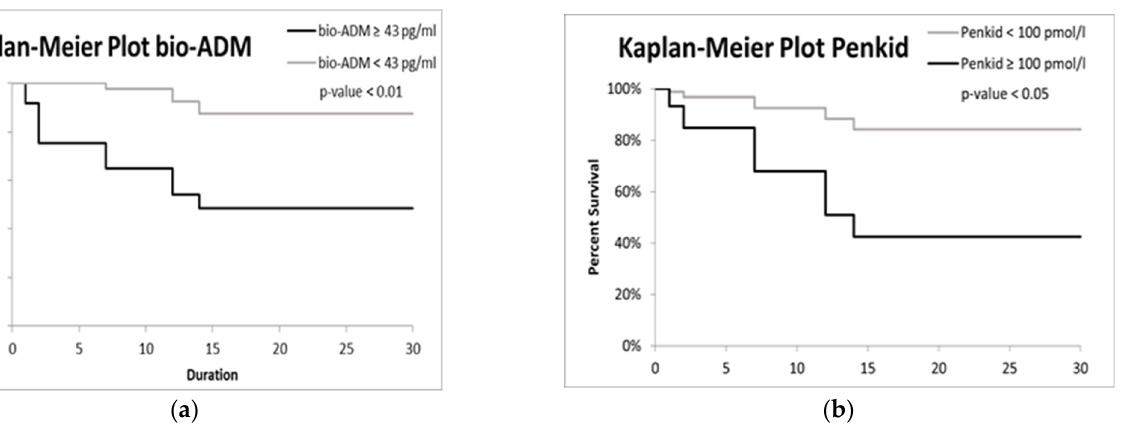
Figure 4. ( a ) Kaplan–Meier Bio-ADM curve. Grey line shows the survival rate for the patients with Bio-ADM values <43 pg/mL in the first 30 days. Black line shows the survival rate for the patients with Bio-ADM values ≥ 43 pg/mL ( p -value 0.003). ( b ) Kaplan–Meier penKid curve. Grey line shows the survival rate for the patients with penKid values <100 pmol/L in the first 30 days. Black line shows the survival rate for the patients with penKid values ≥ 100 pmol/L ( p -value 0,02).